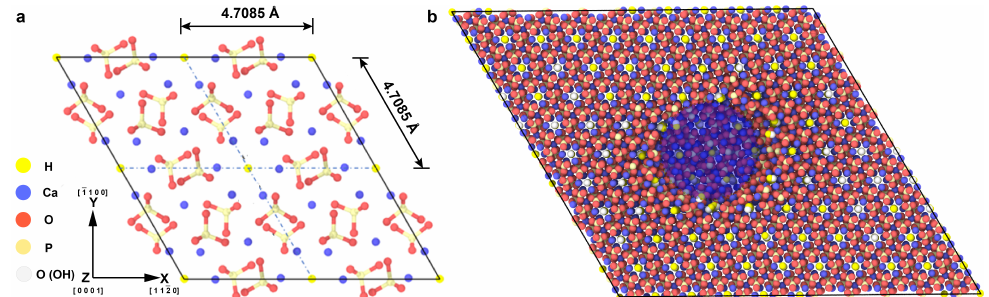
Figure 8. Simulated HAP domain. ( a ) The 44-atom HAP unit cell used as the base for replication. ( b ) Sectioned 44,000 atom HAP domain showing a 30 Å diameter pore at the center (shaded blue for